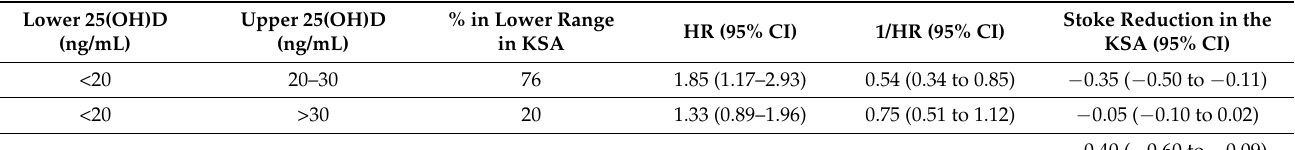
Table 5. Estimate of reduction in stroke incidence rate in the KSA by raising minimum 25(OH)D concentration to 30 ng/mL using 25(OH)D data from [86] and results from a U.S. study [84].